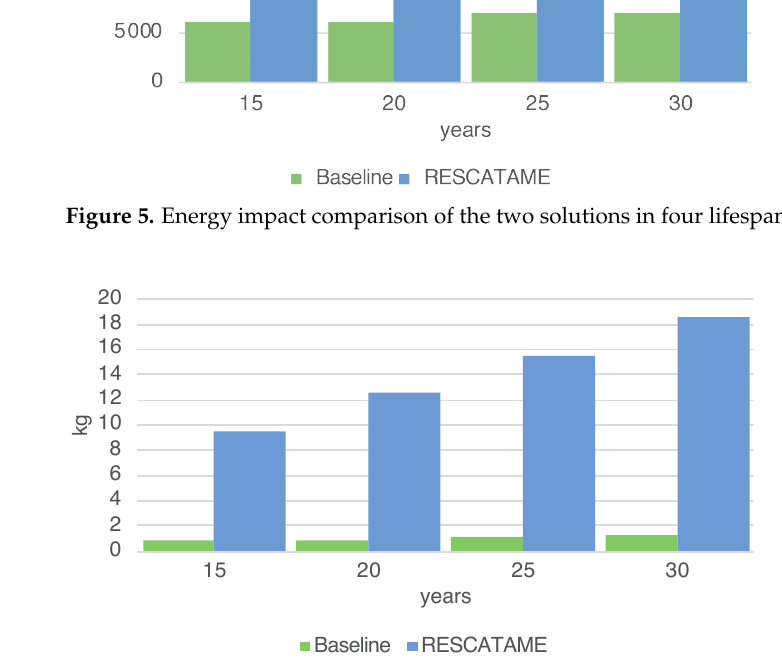
Figure 6. Waste impact comparison of the two solutions in four lifespan scenarios.